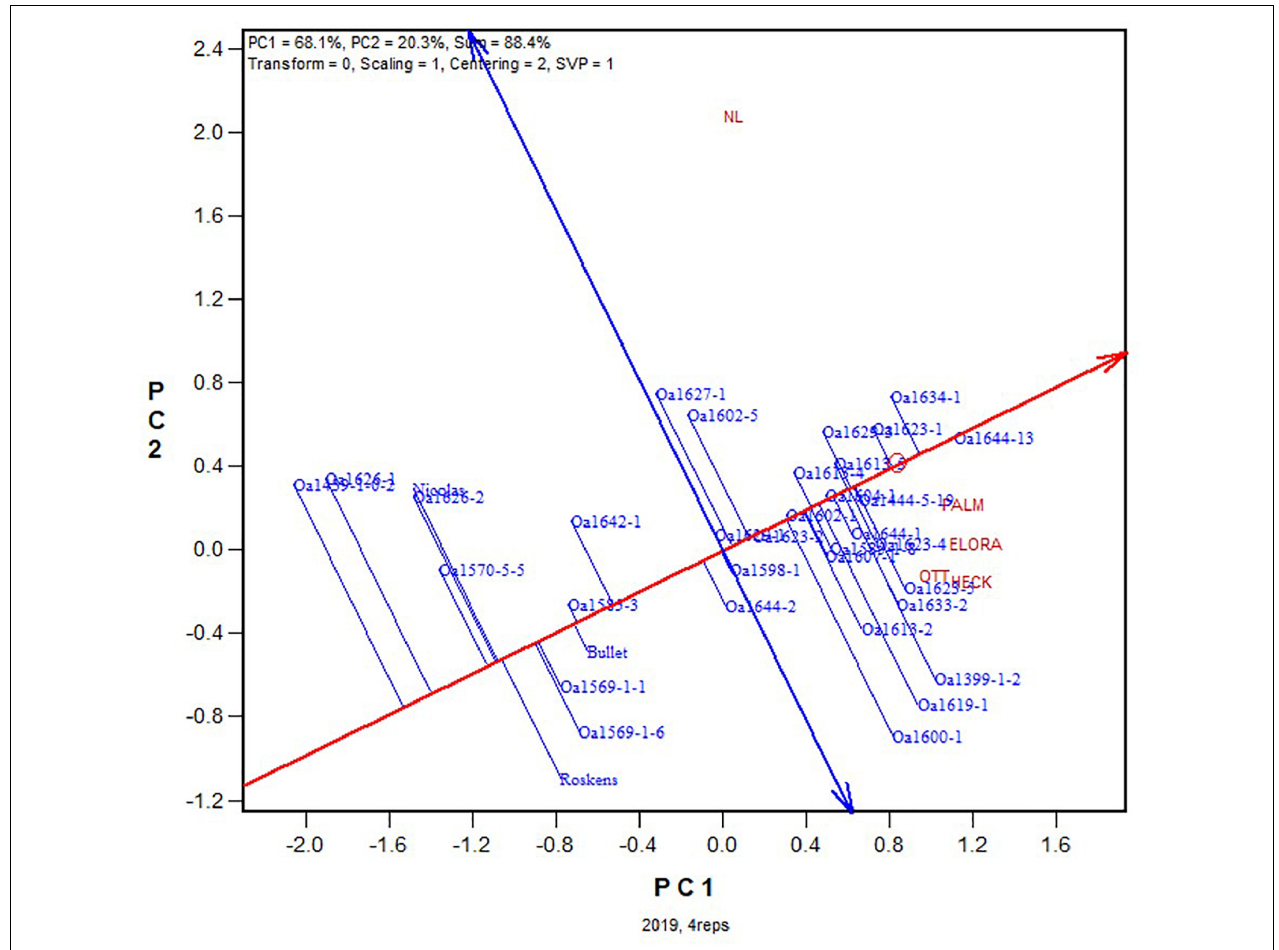
FIGURE 1 | GGE biplot based on the yield data from all four replicates for the 2019 Ontario trials. See Table 1 for the full names of the locations.